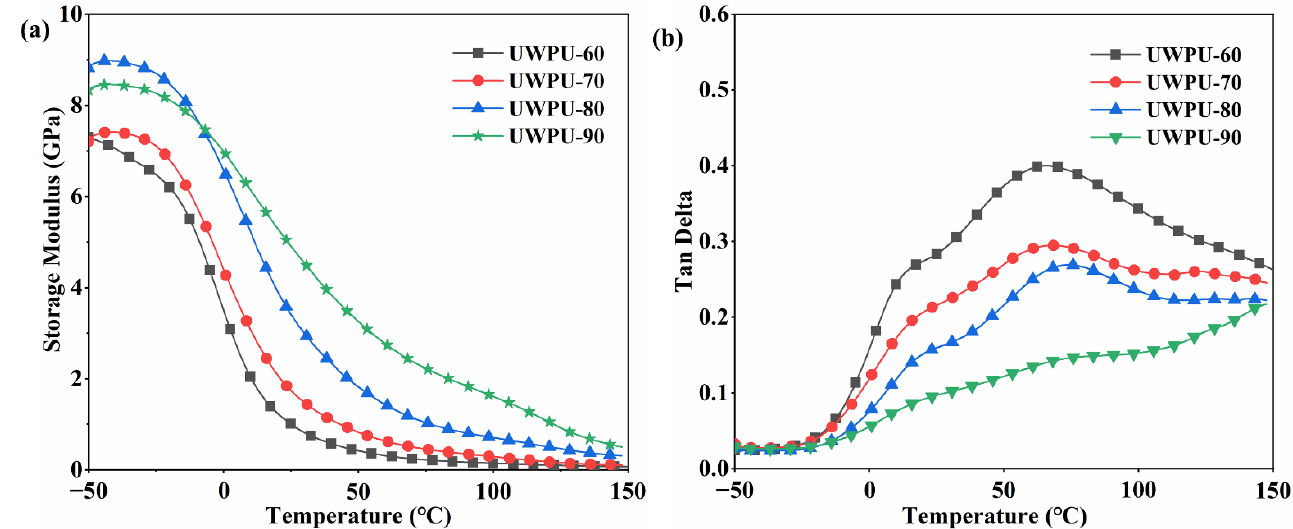
Figure 3. ( a ) Storage modulus and ( b ) tan δ curves of UW PU